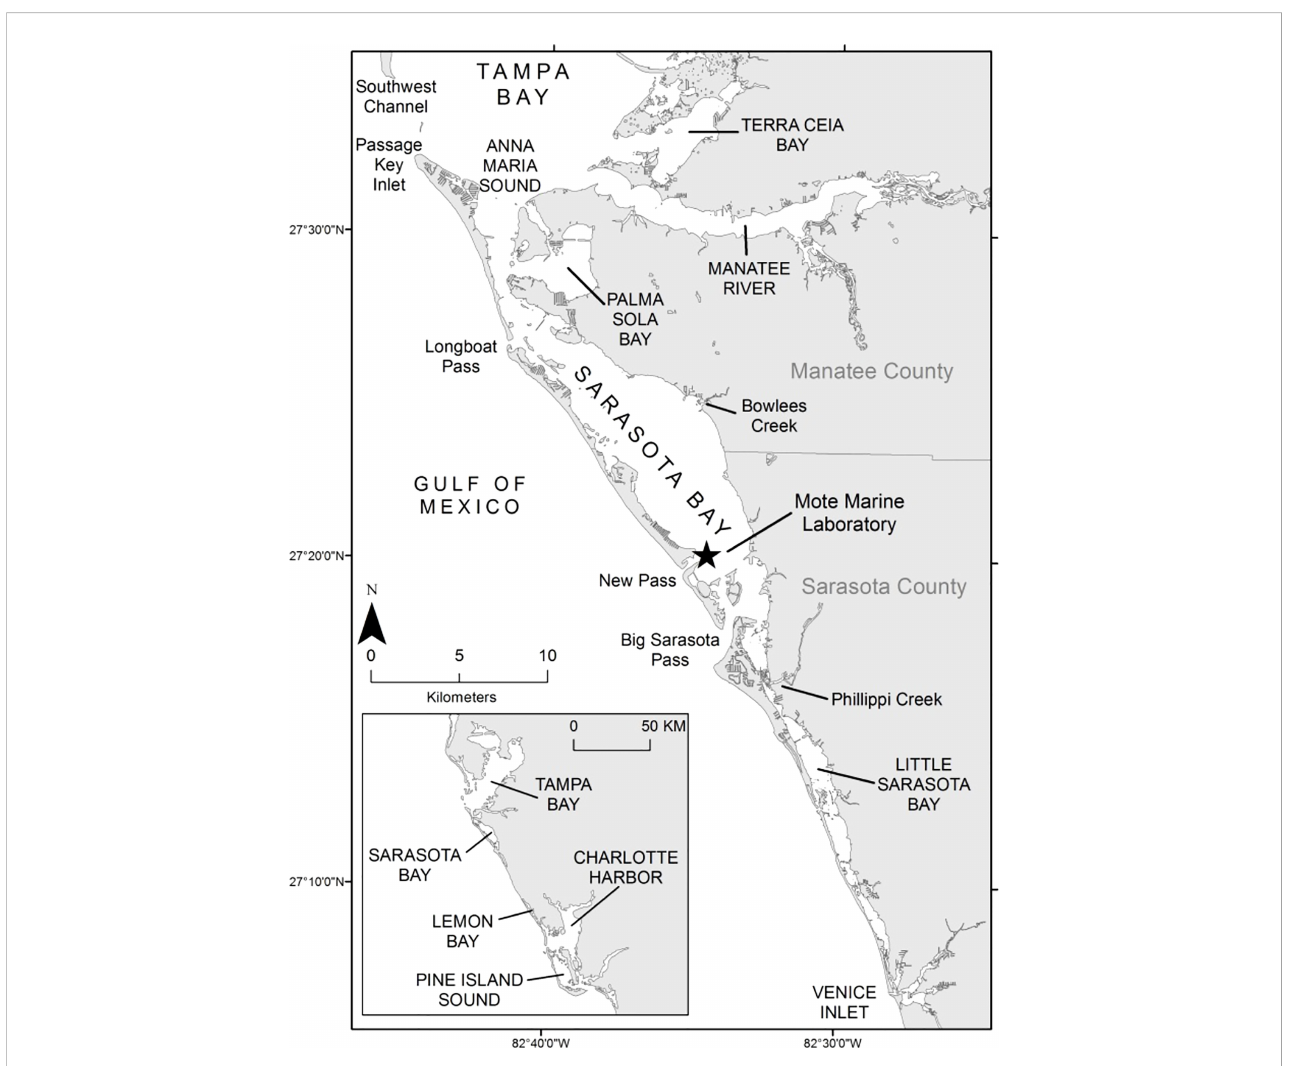
FIGURE 1 Study area of the Sarasota Dolphin Research Program along the west coast of Florida. The home range of the Sarasota Bay dolphin community extends southward from southern Tampa Bay to Venice Inlet. Other dolphin communities live in adjoining